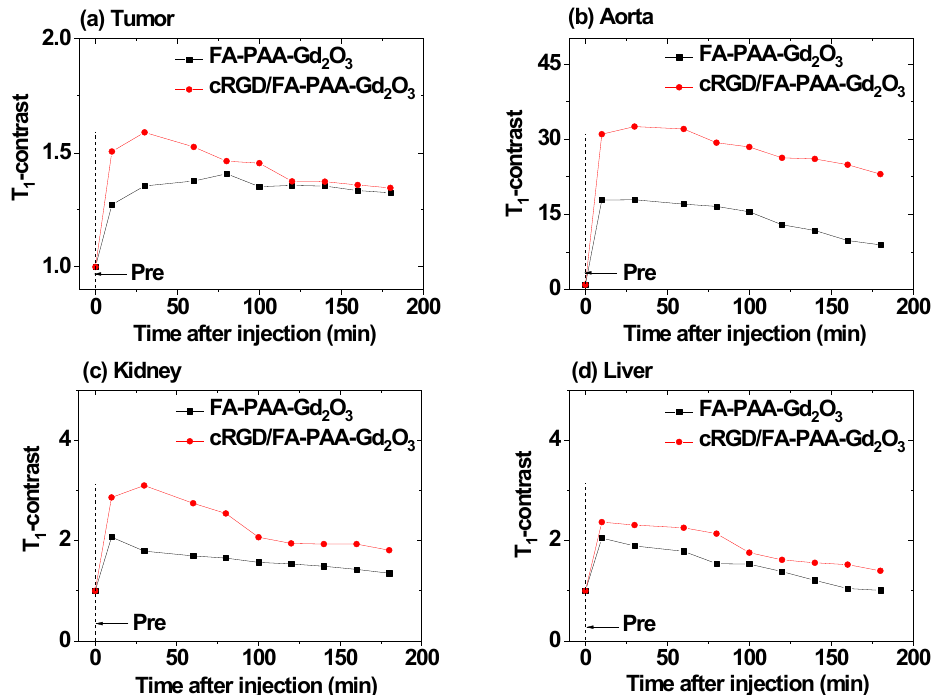
Figure 9. Plots and comparison of T 1 -contrast ROIs between the FA-PAA-Gd 2 O 3 and cRGD/FA-PAA-Gd 2 O 3 nanoparticles in ( a ) the tumor, ( b ) aorta, ( c ) kidneys, and ( d ) liver as a function of time before and after intravenous injection of the nanoparticle suspension samples into mice tails. T 1 -contrast ROI = SNR (t)/SNR